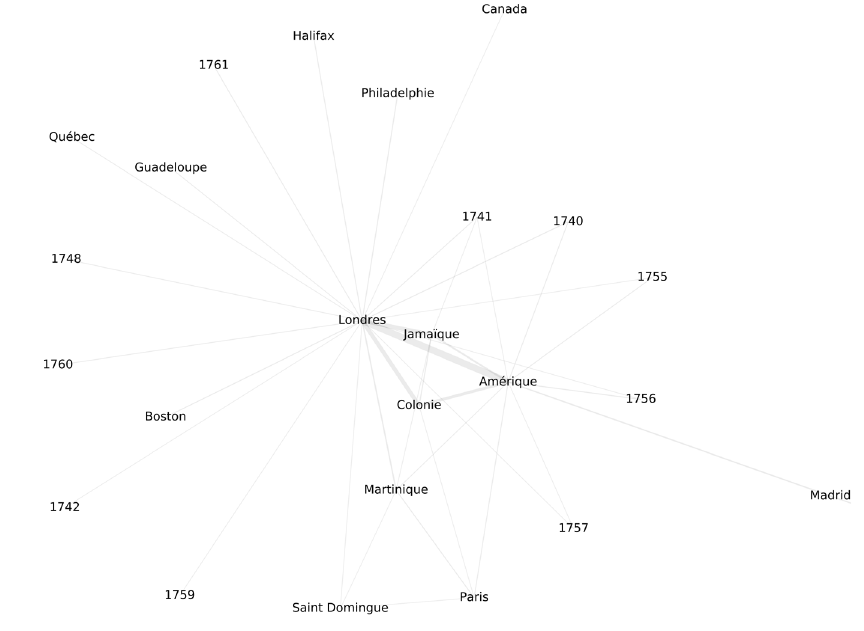
Fig. 6 A copresence graph that shows the dominant association between London, America, and the colonial world within the corpus While every French colony in the graph is linked to London, not a single foreign colony is linked to France. Similarly, ten years of publication are linked to London, indicating relatively numerous discussions of colonial America in articles received from the British capital; none are linked to Paris. The Gazette thus suggests to its readers that the mental distance between France and its colonies is much larger than that between Britain and its own empire, or even that the French empire is somehow a more important presence in London public discourse than in its French counterpart. It is but a short step from there to the conclusion that France had already lost the (mental) battle for America, long before the Treaty of Paris that put an end to the Seven Years’